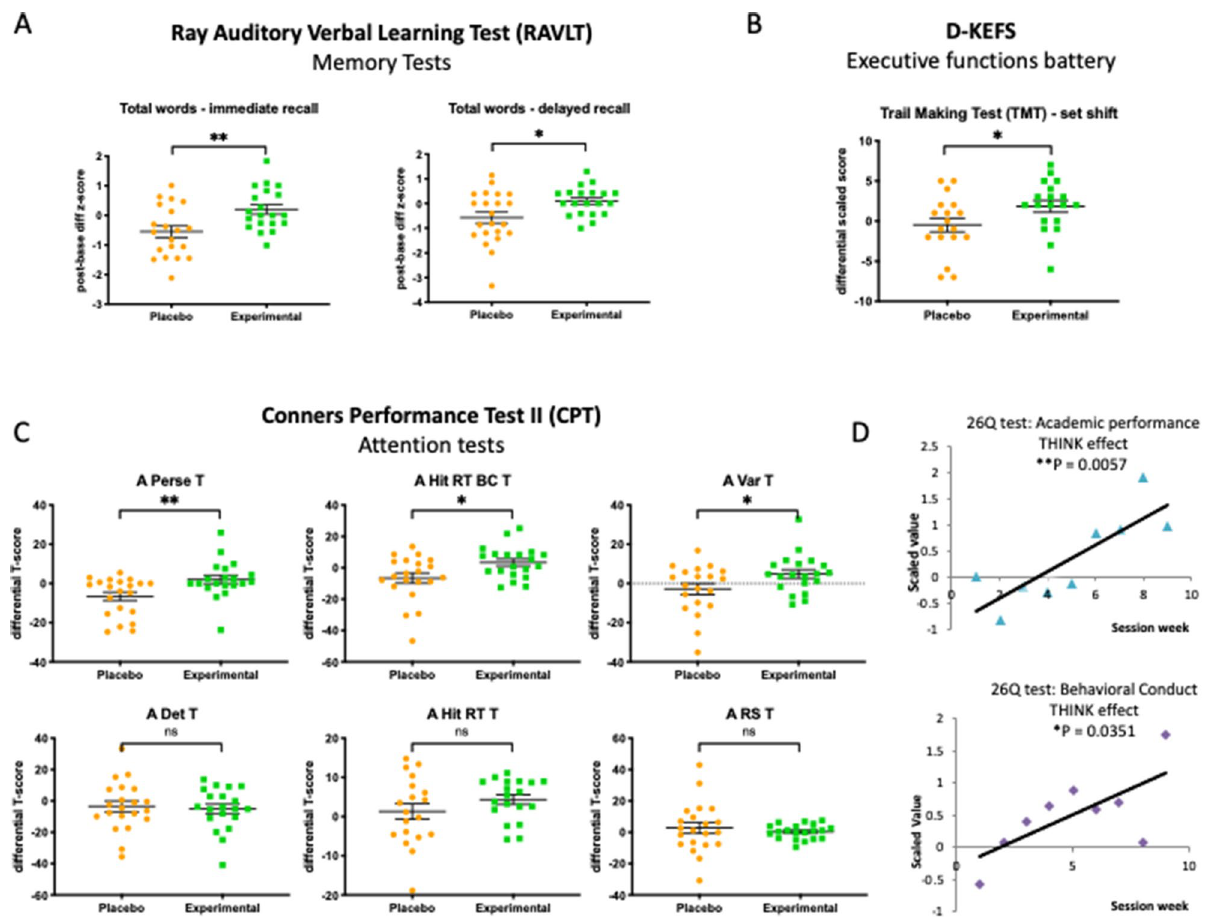
Figure 2. Results from neuropsychological tests, computerized tests and performance questionnaires. 41 subjects (21 in the placebo group and 20 in the experimental group) completed a panel of neuropsychological tests to evaluate global cognitive functioning, attention and executive functions before and after FSCT. Differential scores (post-FSCT vs. pre-FSCT) were calculated for ( A ) Ray Auditory Verbal Memory Test (RAVLT) immediate and delayed recall (differential z-scores normalized by age and gender of the subject), ( B ) Delis–Kaplan Executive Function Test (D–KEFS) Trail Making Test part 4 (TMT-4) * p = 0.0436, ( C ) Conners Performance Test (CPT II) (Unpaired t-test, * p < 0.05 ** p < 0.01). ( D ) 26Q questionnaire concerning academic performance (upper panel) and behavioral conduct (lower panel). For each measure, the “THINK effect” was calculated as a subtraction of the arithmetic mean of the results of the experimental group B minus the arithmetic mean of the results of the placebo group A), and its value is shown for each session week along 9 weeks of observation (linear regression, * p < 0.05 ** p <